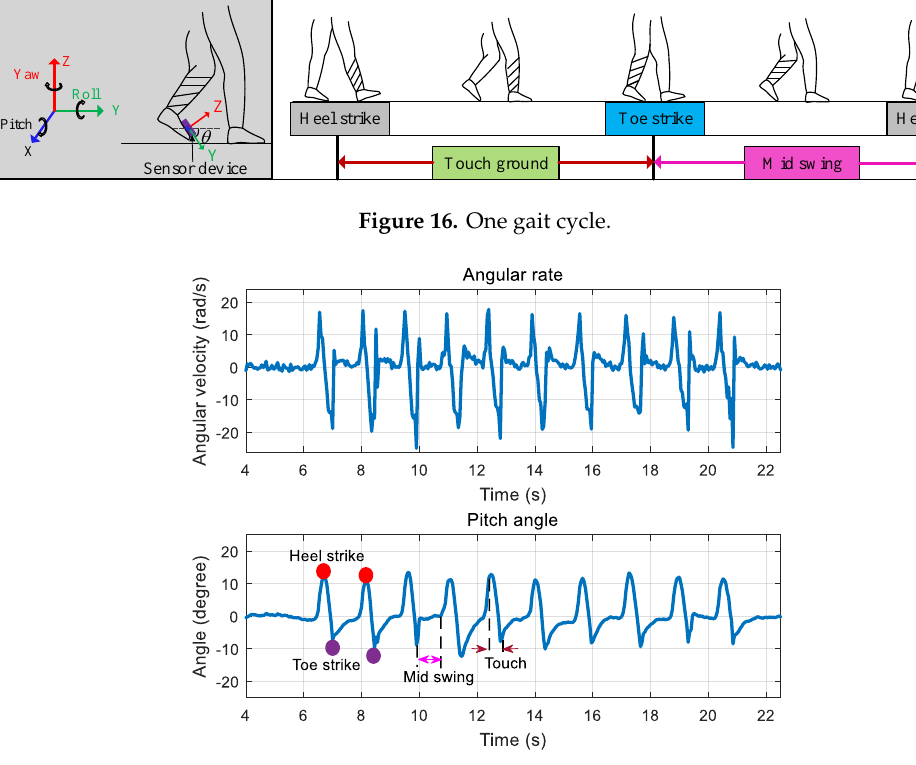
Figure 17. Measurement of foot attitude with the developed sensor device.